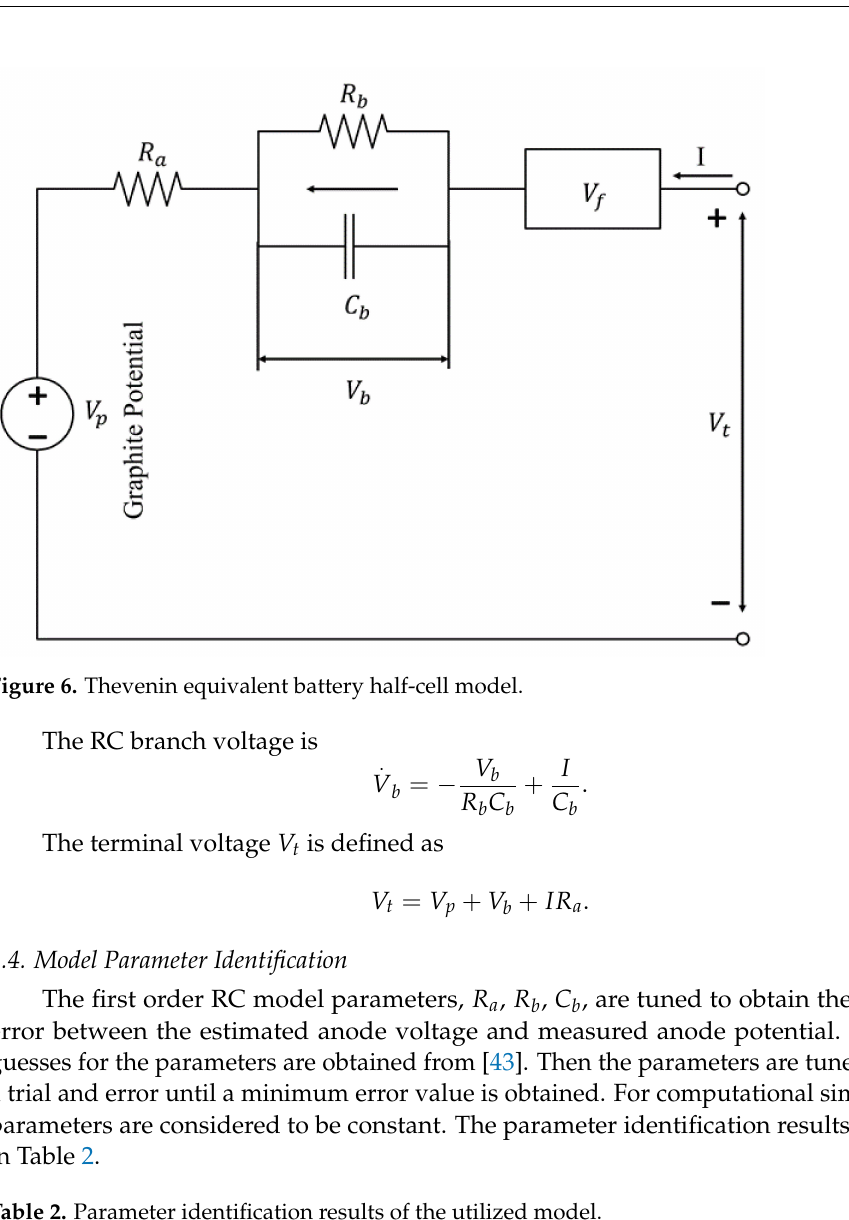
Table 2. Parameter identification results of the utilized